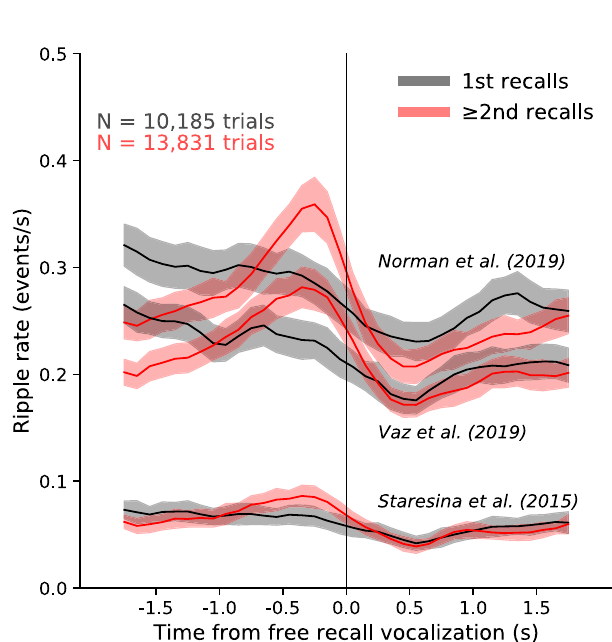
Fig. 4 | Relationship between cortical ripple amplitude and local spiking. A LocationsofthemicroelectrodearrayswithrespecttofournearbyiEEGchannels in one participant (bottom left). Right, Intraoperative photo of implanted array in the anterior temporal lobe before and after placement of an iEEG grid over the it. Bottom, Schematic of scalp, skull and cortex with respect to one iEEG channel on